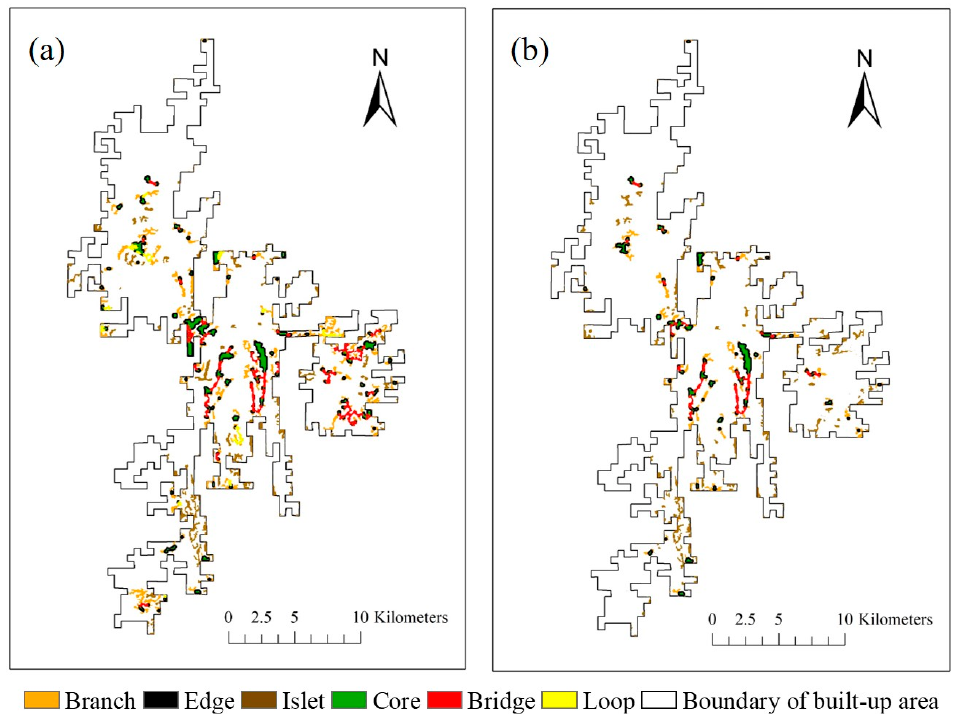
Figure 9. Morphological spatial patterns of historical forests in ( a ) 1976 and ( b ) 2018. Table 4. Number of morphological spatial patterns.